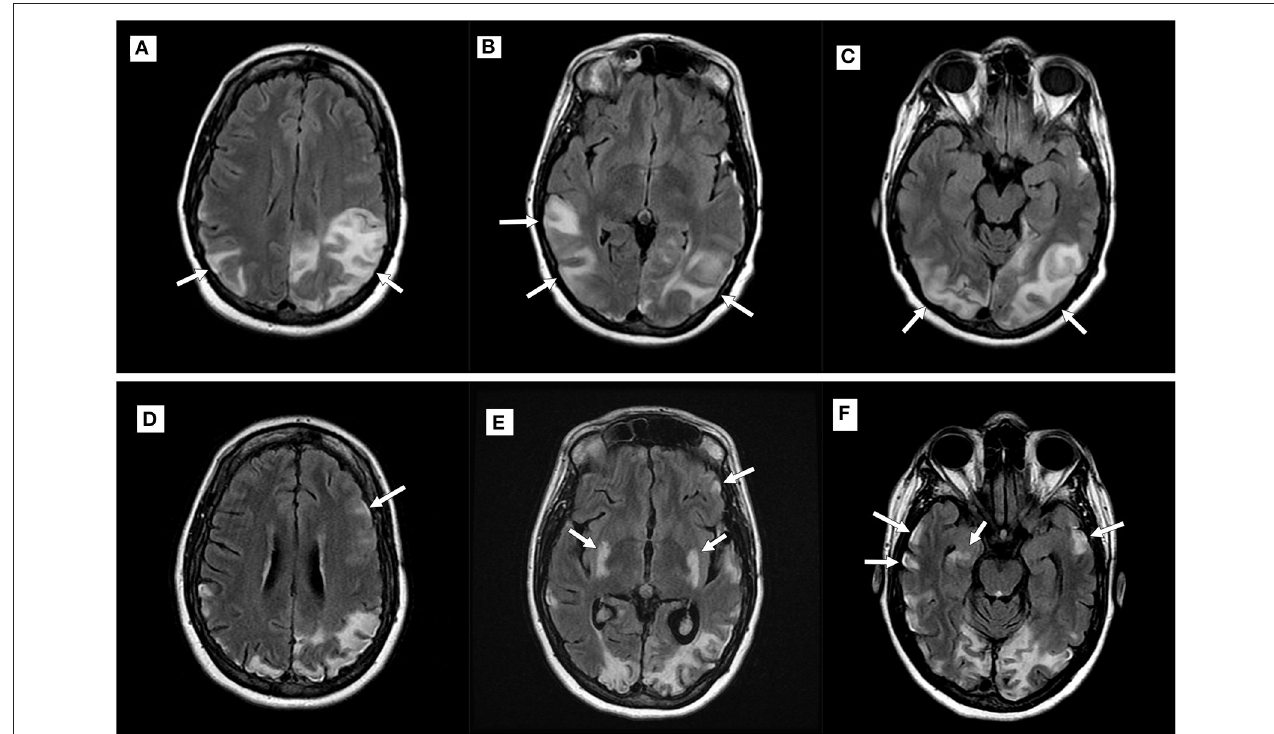
FIGURE 2 | Imaging progression in a patient with mitochondrial encephalomyopathy, lactic acidosis, and stroke-like episodes (MELAS). Top row (A–C) : Axial T2 fluid-attenuated inversion recovery (FLAIR) imaging demonstrating new hyperintensities (white arrows) within the parietal and occipital lobes during an acute attack; Bottom row (D–F) : Imaging performed during a subsequent MELAS episode with new putaminal and bilateral temporal hyperintensities (white arrows). Note volume loss seen in previously affected